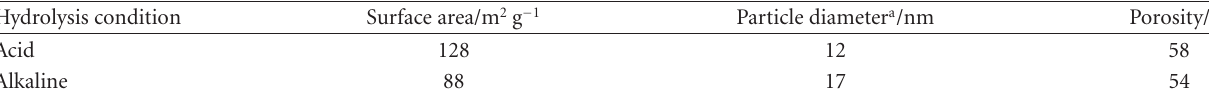
Table 1: Morphological parameters determined by the BET method for TiO 2 nanoparticles synthesized in di ff erent hydrolysis conditions. Hydrolysis condition